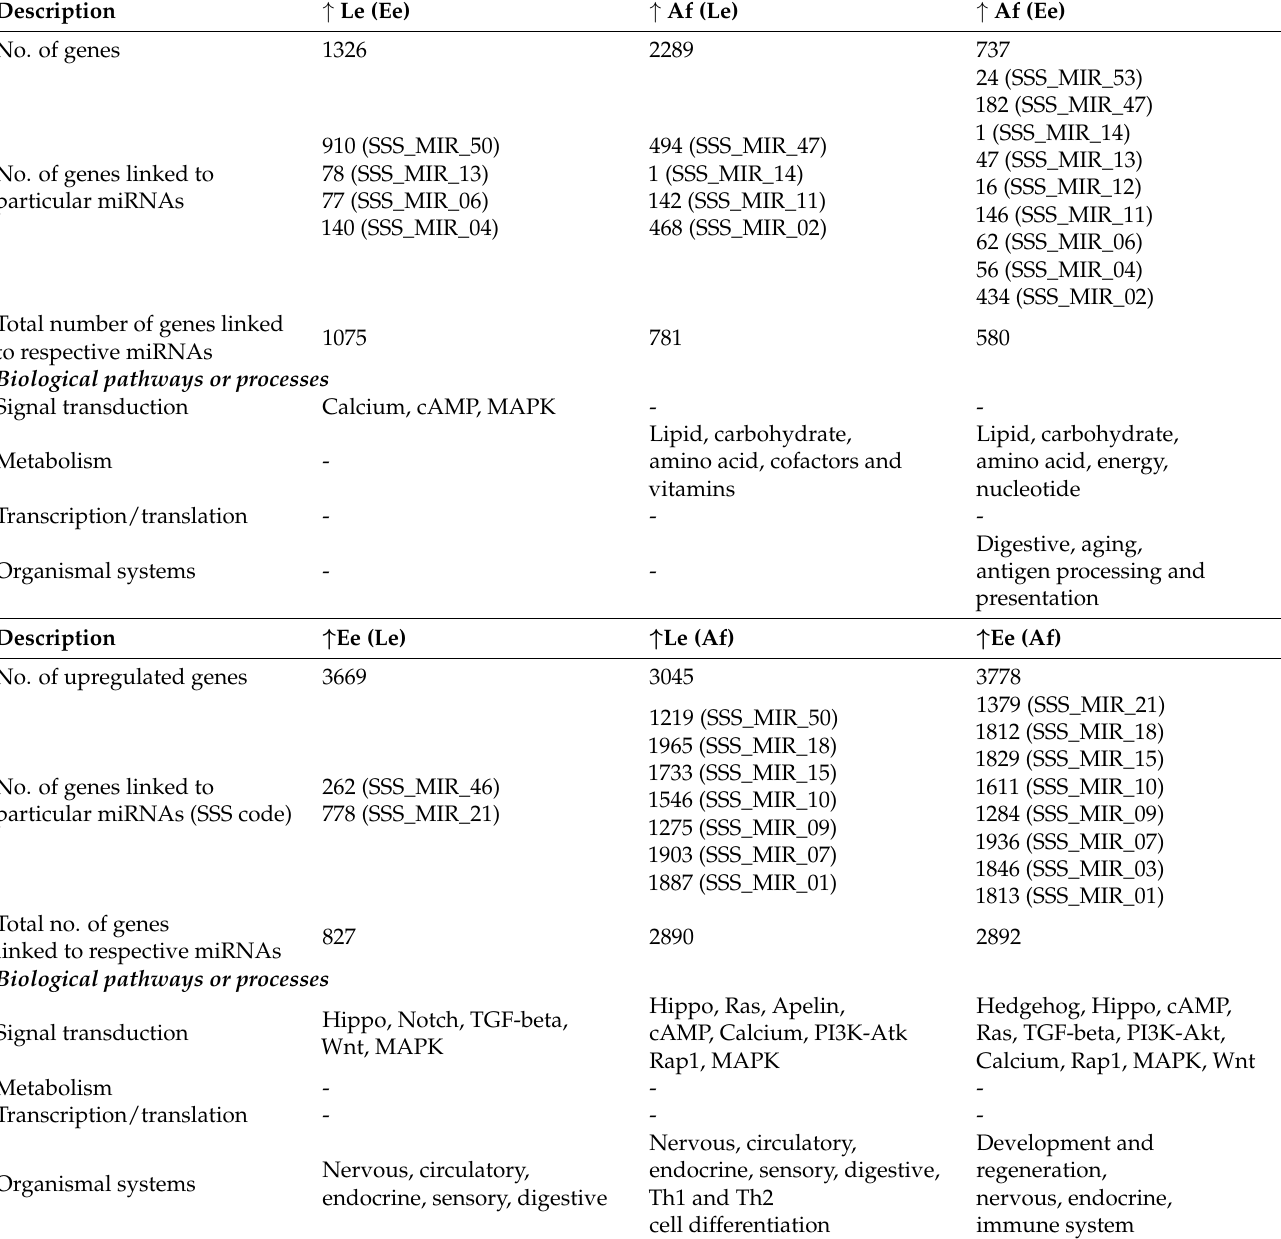
Table 2. MicroRNAs (SSS_MIR codes; cf. Table S2) linked to genes whose transcription (mRNA) was significantly increased ( ↑ ) in a particular developmental stage (relative to another stage) of Sarcoptes scabiei (cf. colour codes in Figure 1). Stages: Ee:—early egg, Le—late egg (Le) and Af—adult female. Enriched biological pathways or processes that were inferred to be linked to increased transcription are